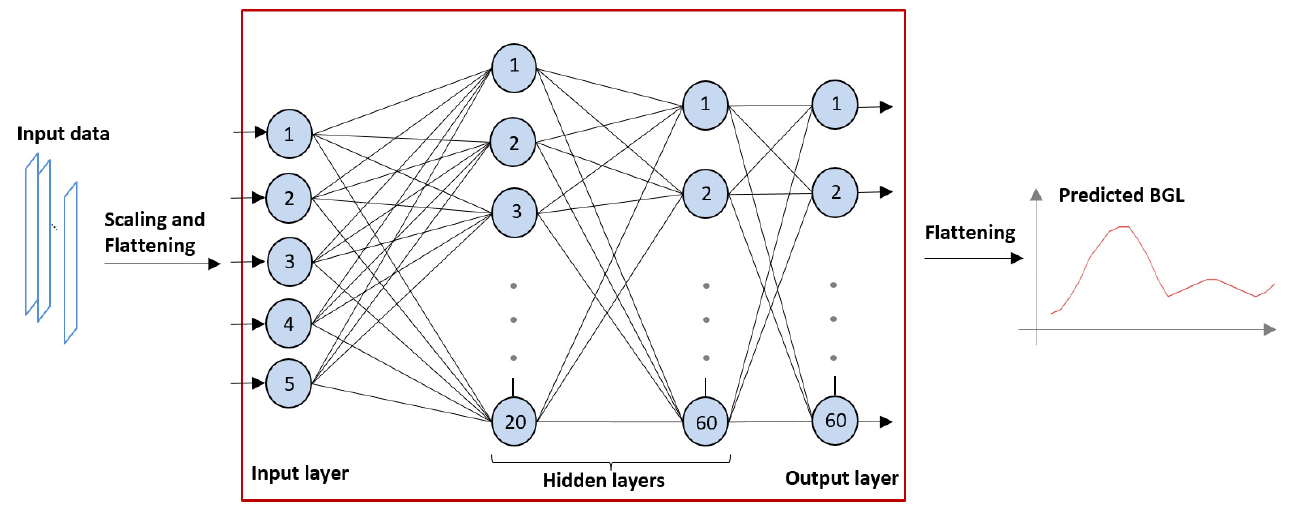
Figure 2. Structure of the feed-forward neural network (FNN) used for prediction. Numbered circles represent neurons organized in layers.